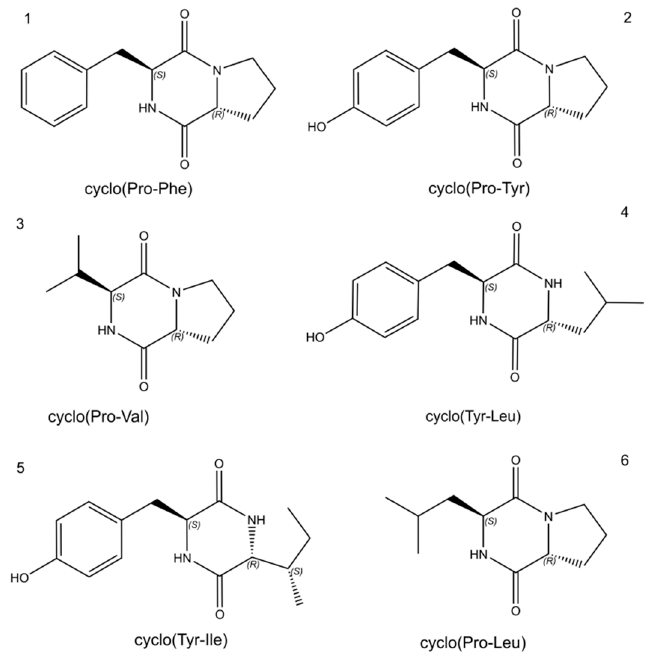
Figure 3. Chemical structures of cyclic dipeptides acting as QS signaling molecules produced by S.